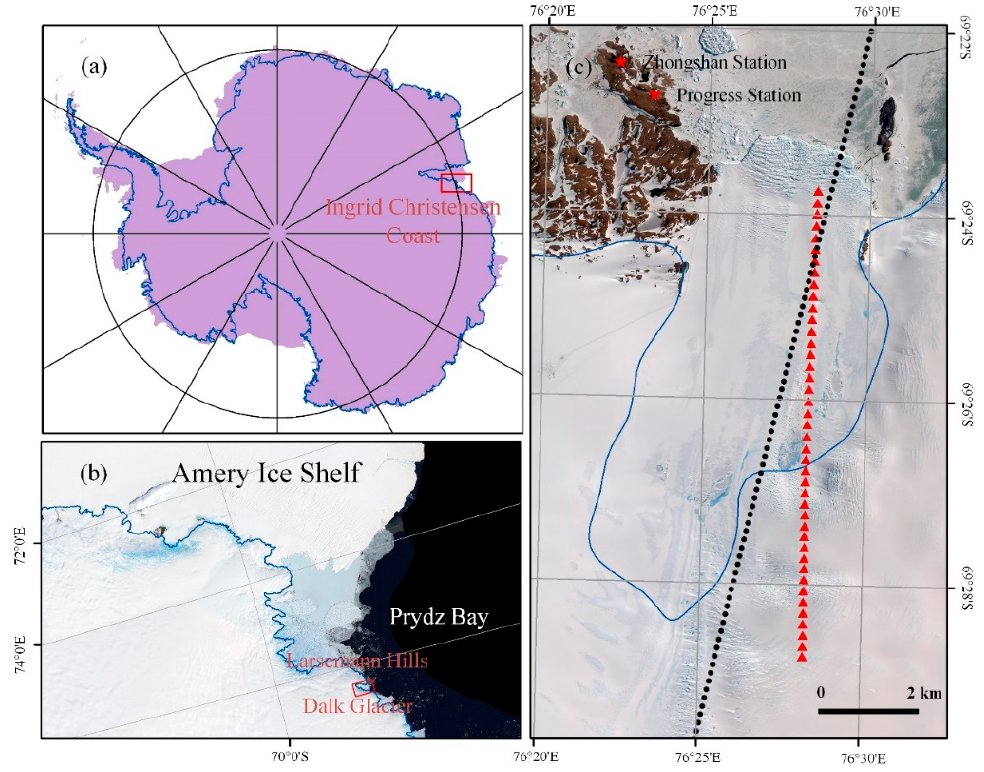
Figure 1. ( a ) and ( b ) show the location of Dalk Glacier along the Ingrid Christensen Coast, Figure 1. (a) and (b) show the location of Dalk Glacier along the Ingrid Christensen Coast, East Antarctica. (c) An overview of Dalk Glacier. The background is a Worldview-2 image acquired on 2 January 2016. Blue lines indicate the location of the grounding line. Black dots are ICESat/GLAS